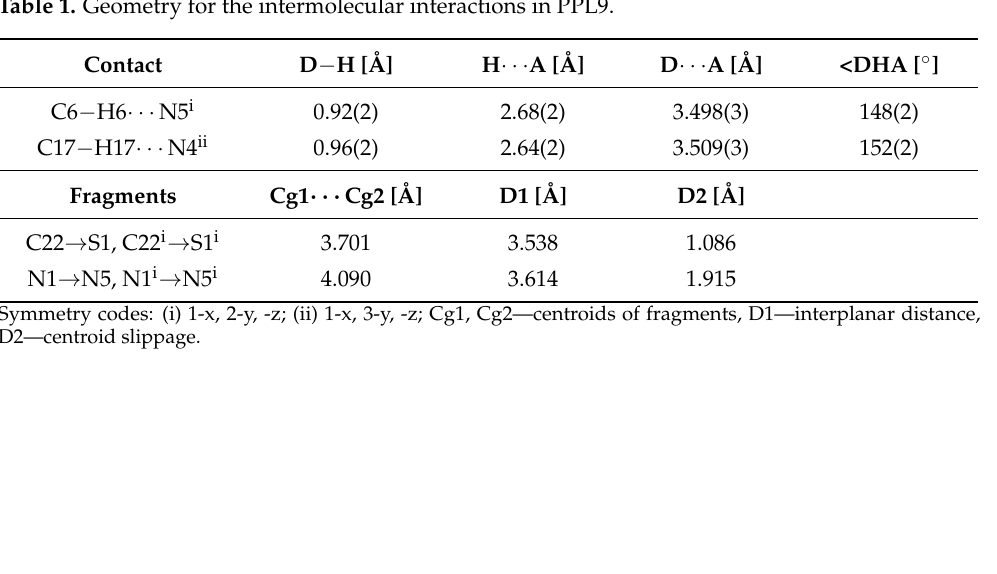
Figure 1. Asymmetric unit for trans -PPL9 with the numbering scheme, the atomic displacement parameters for the non-hydrogen atoms were drawn at the 35% probability level. Table 1. Geometry for the intermolecular interactions in